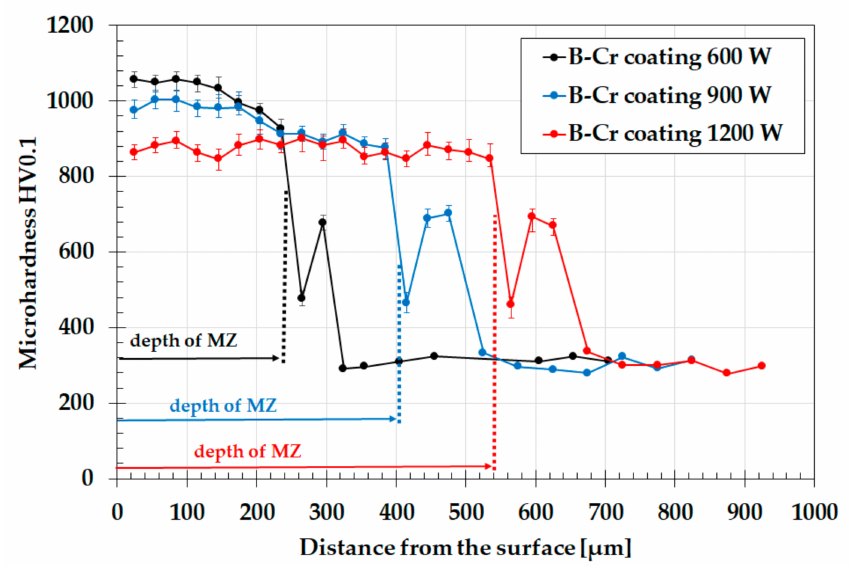
Figure 7. Microhardness profiles of B-Cr coatings produced using laser processing of diffusion borochromized